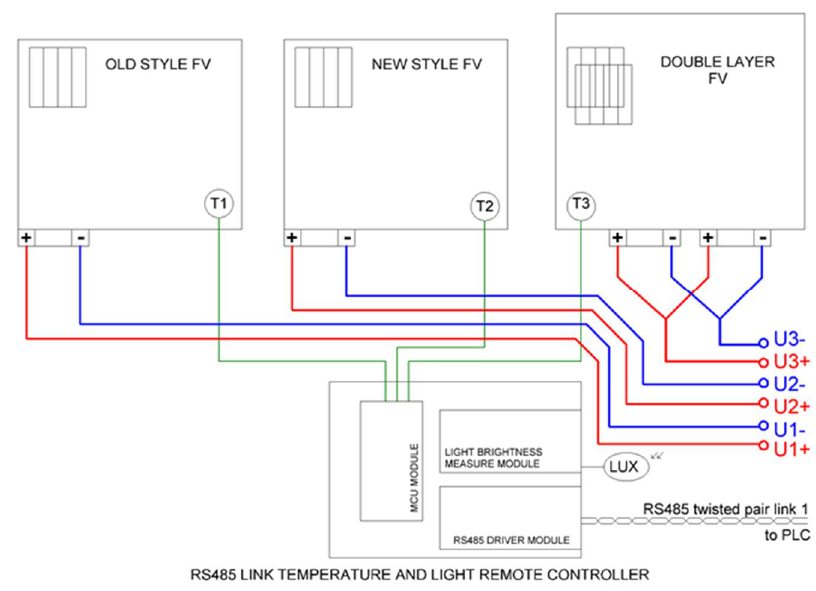
Figure 1. Wiring diagram for 870 W solar power plant modules.